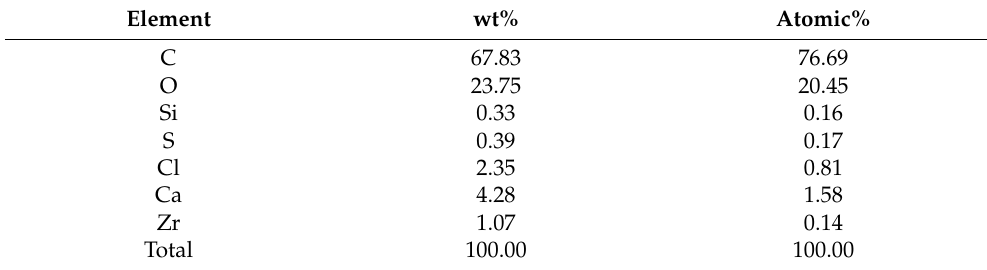
Figure 8. Micromorphology of pure cement slurry and resin cement slurry. ( a ) Micromorphology of CR-0; ( b ) Micromorphology of CR-30. Table 5. Element content of the resin (Spectrum 1).